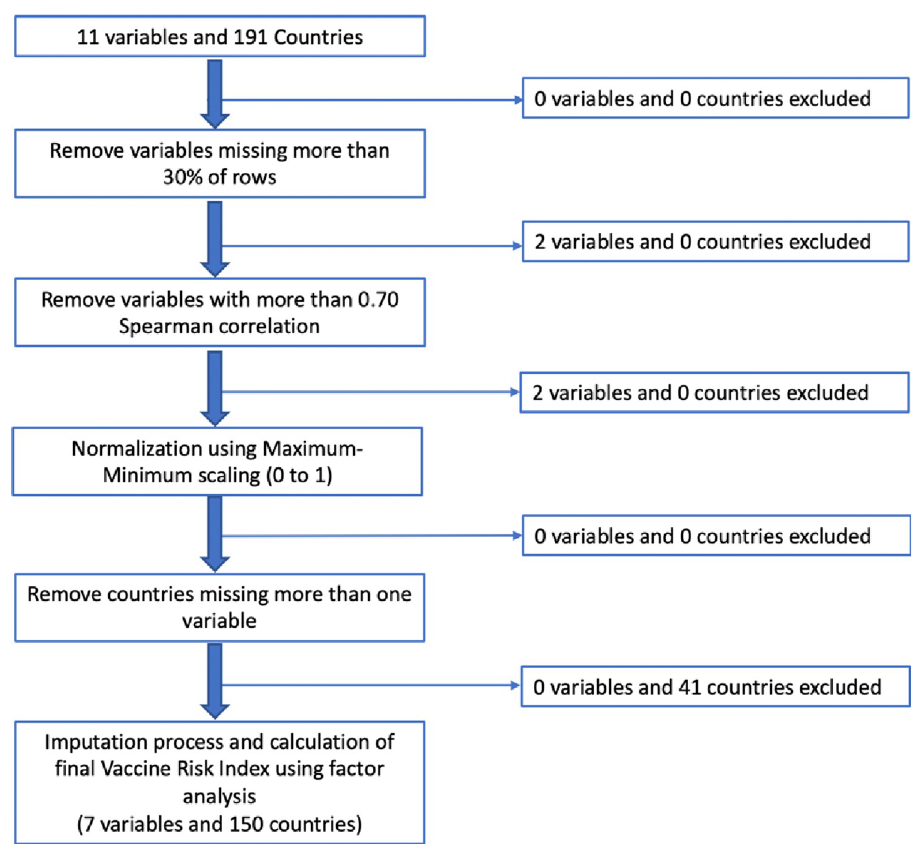
Fig 2. Steps in creating the VRI. The boxes show the initial number of variables and intermediate steps to filter the variables and countries for the final vaccine risk index factor analysis calculation.